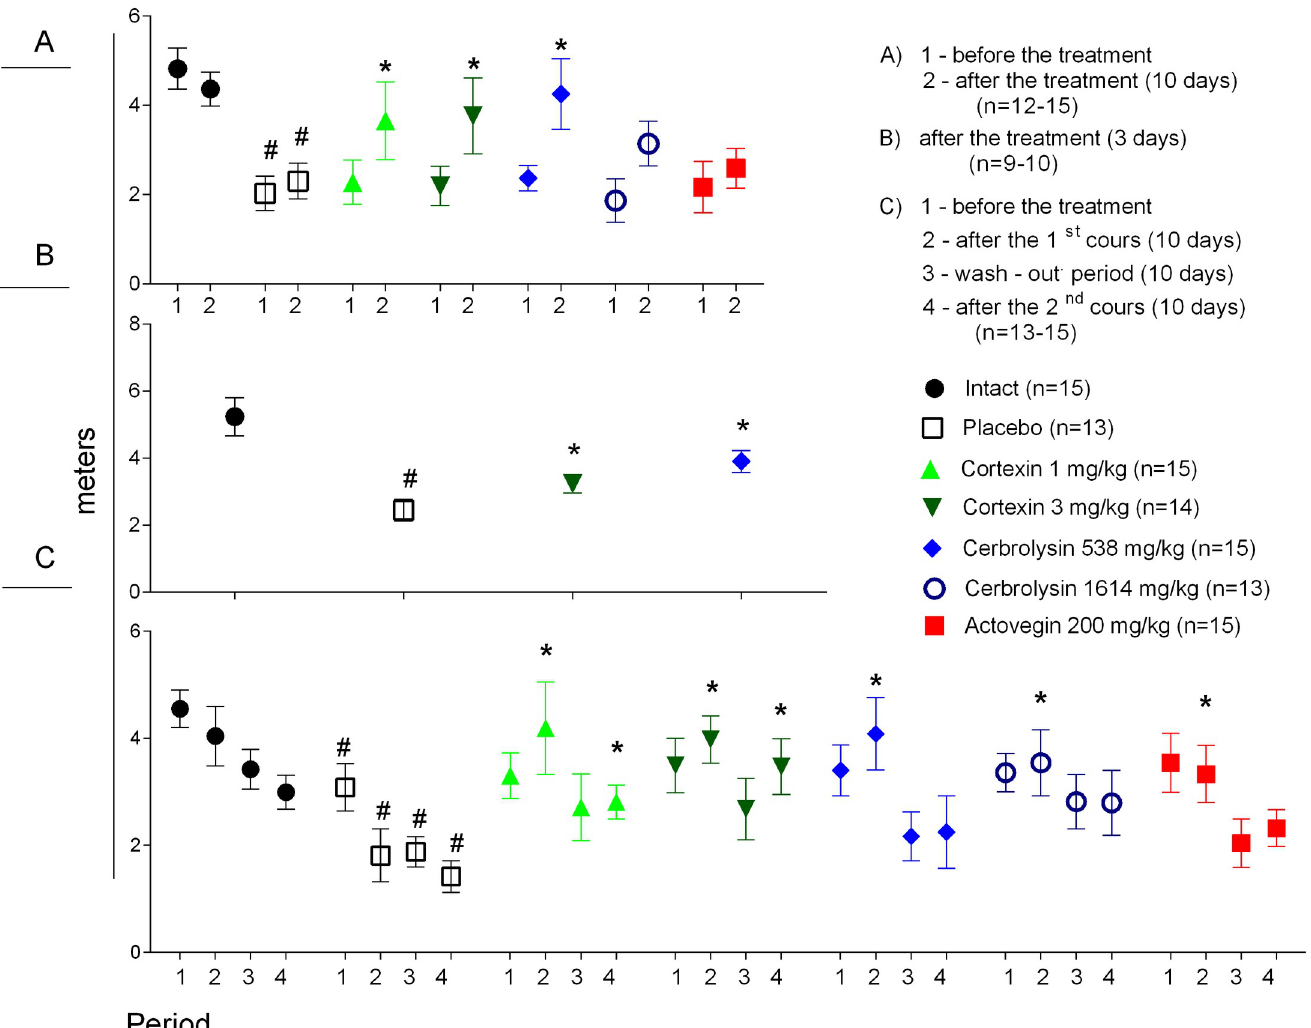
Fig 6. Motor activity in Open field test in rats with acute brain ischemia (after 10 (A) or 3 (B) days of treatment) and in rats with chronic brain ischemia (C). #–p < 0.05 compared to Intact; � –p < 0.05 compared to placebo (Kruskal-Wallis rank analysis and the Dunn post-hoc test); data shown as the mean ± SEM.